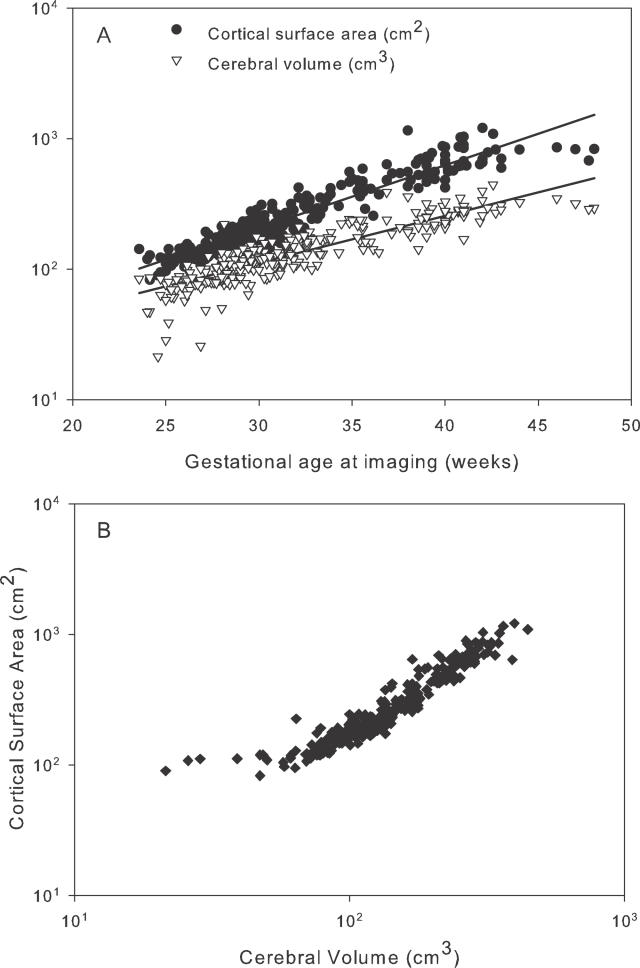
Cerebral Volume and Surface Area Growth in Preterm Infants(A) Values for cerebral volume and cortical surface area for 113 infants imaged serially between 23 and 48 wk gestation (274 scans) displayed on log-log coordinates and related to gestational age at scan, showing linear relationships for both variables.(B) Scaling of cortical surface area relative to cerebral volume shown as a scatter plot in log-log coordinates of the cortical surface area s against cerebral volume v determined from each of these 274 scans. The linear relationship apparent for volumes greater than about 45 cm3 indicates a power law scaling of the form s = kvα, where α is the scaling exponent and k is a constant. For a three-dimensional object that maintains its shape with changing size, the exponent α would take the value 2/3 (since area scales as length squared and volume as length cubed). For the data in this plot, in contrast, a good fit (for v > 45 cm3) is obtained with α = 1.29 (95% confidence interval 1.25–1.33).